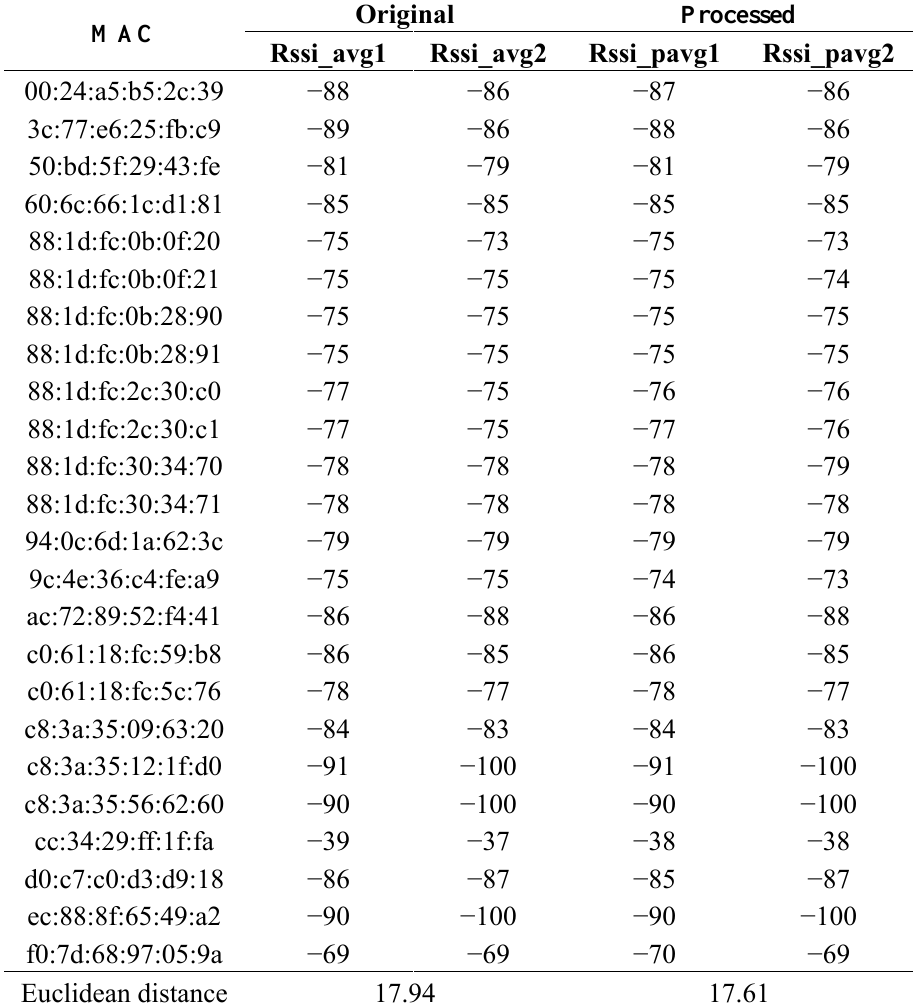
Table 2. Euclidean distance of two collections at the same position. MAC